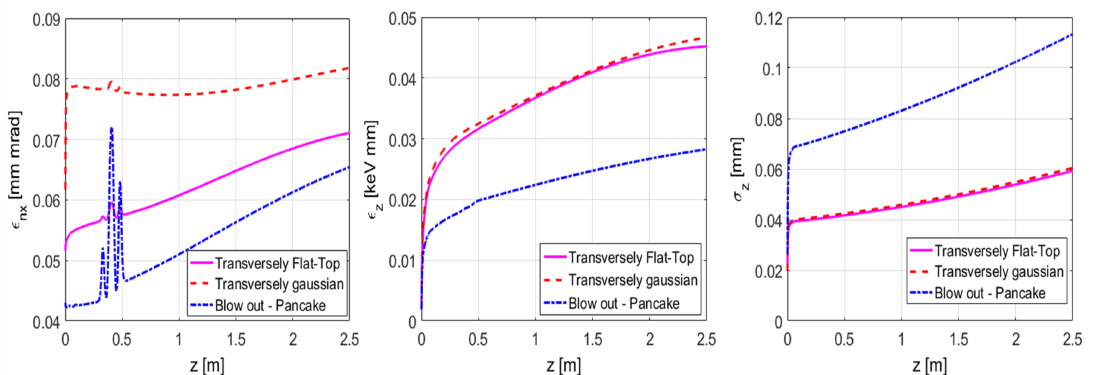
Figure 9. Evolution of transverse emittance, longitudinal emittance and bunch length from the cathode to the linac entrance for the working-points represented in Figure